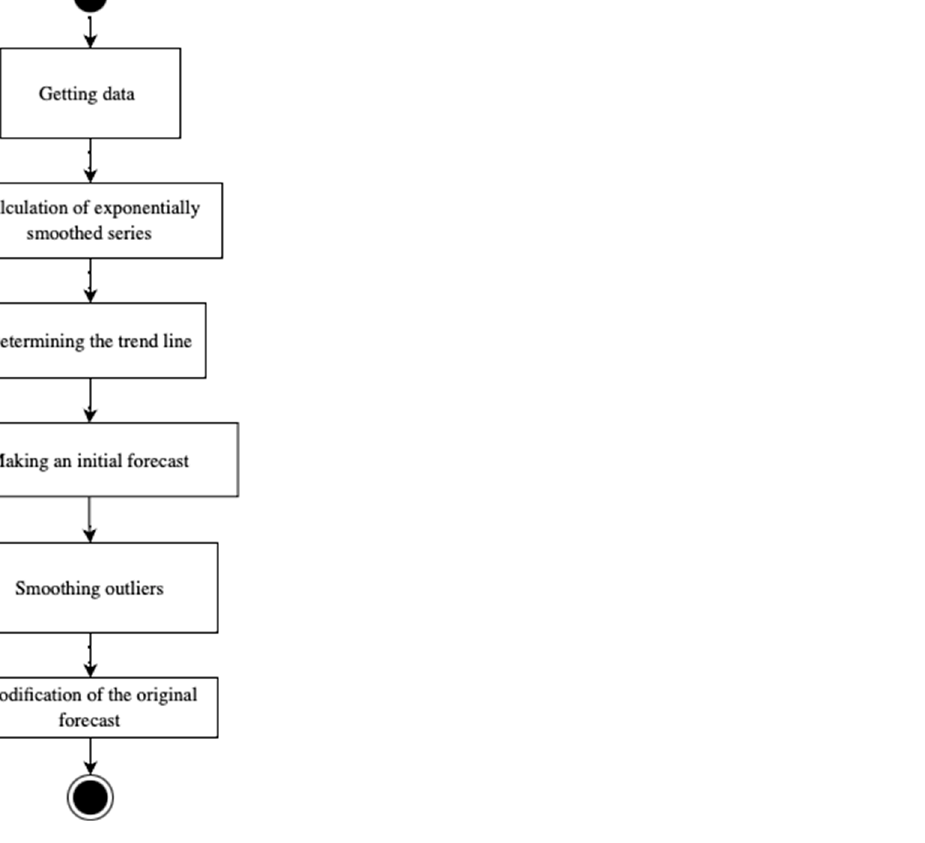
Table 10. Final evaluations of different forecasting methods.